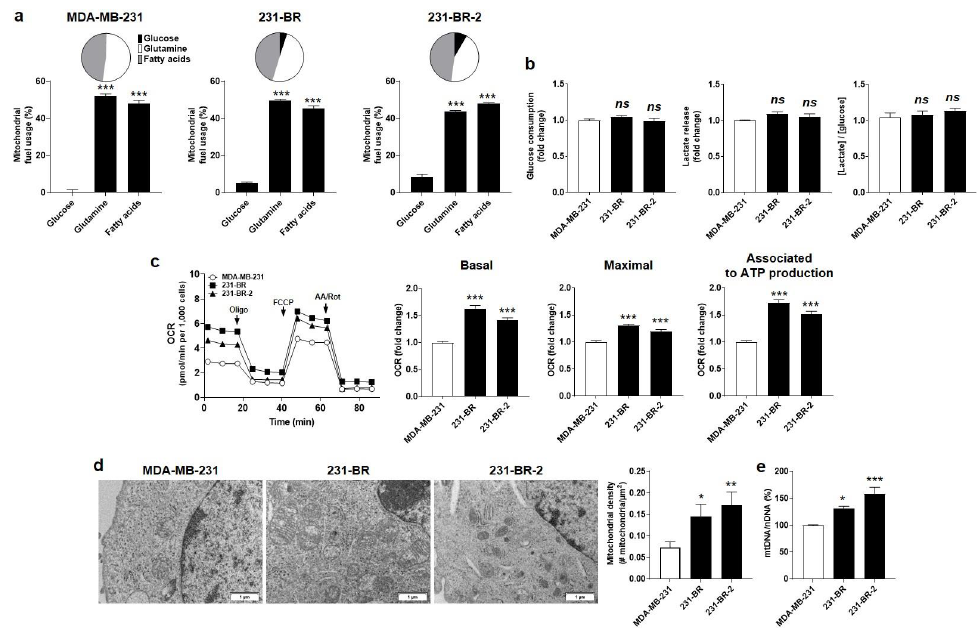
Figure 2. Brain-seeking variants are more oxidative than parental MDA-MB-231 human breast cancer cells. ( a ) Mitochondrial fuel usage of MDA-MB-231 ( left , n = 14), 231-BR ( middle , n = 14 – 16), and 231-BR-2 ( right , n = 14 – 15) cancer cells was determined using the Fuel Flex test kit (Agilent) on a Seahorse XF96 bioenergetics analyzer. Data are presented as pie and column graphs, where total fuel usage = 100%. ( b ) Glucose consumption ( left , n = 11 – 16), lactate production (middle, n = 16 – 17), and the lactate/glucose ratio ( right , n = 13 – 16) were determined from measurements in deproteinized cell supernatants using an enzymatic CMA600 analyzer. ( c ) Basal ( left , n = 29 – 32) and maximal ( middle , n = 28 – 32) oxygen consumption rates (mtOCRs), as well as the OCR of the cells associated to mitochondrial ATP production ( right , n = 29 – 32), were measured using a XF Cell Mito Stress Test kit (Agilent) on a Seahorse XF96 bioenergetics analyzer. Representative Seahorse traces are shown on far left. ( d ) Transmission electron microscopy pictures of the cells are shown on the left (bars = 1 µm), and the mitochondrial density is quantified on the right graph ( n = 6 – 12). ( e ) Mitochondrial DNA/nuclear DNA (mtDNA/nDNA) cell content determined using RT-qPCR ( n = 5). All data are shown as means ± SEM. * p < 0.05, ** p < 0.01, *** p < 0.005, ns: p > 0.05; compared to first column; using one-way ANOVA with Dunnett’s post hoc test ( a – c , e ).